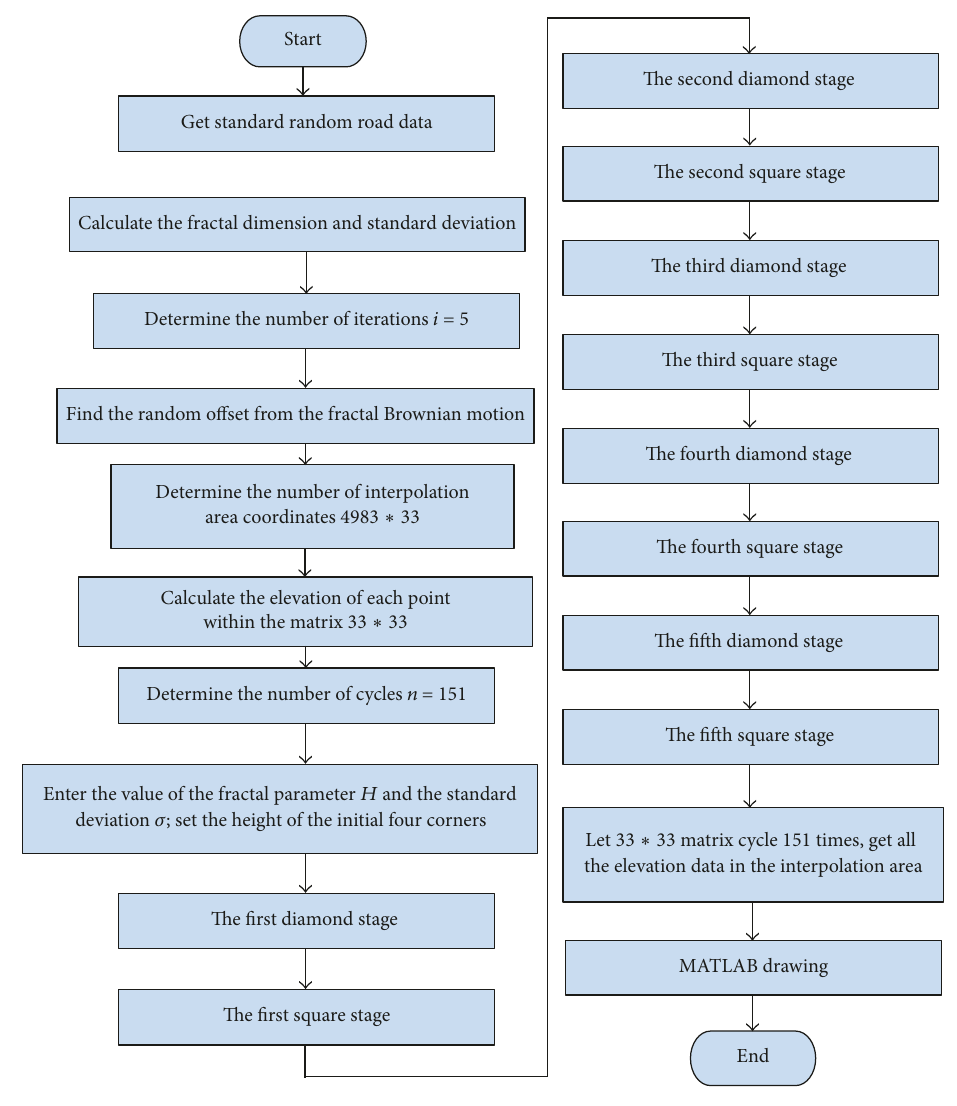
Figure 2: Algorithm flow